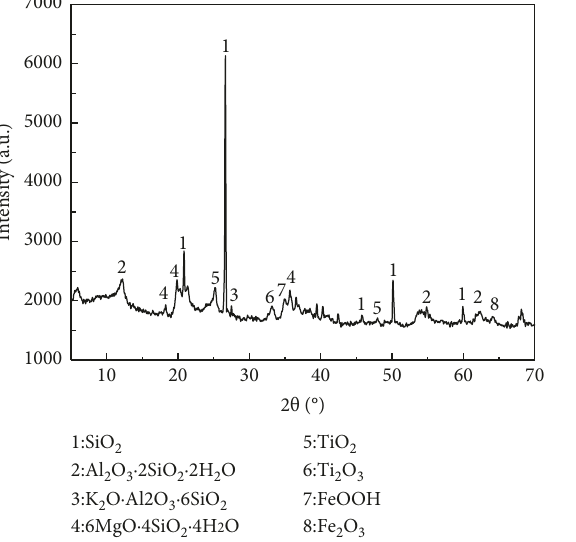
Figure 12: Relationship curve between main diffraction peaks of SiO 2 and the amount of HA